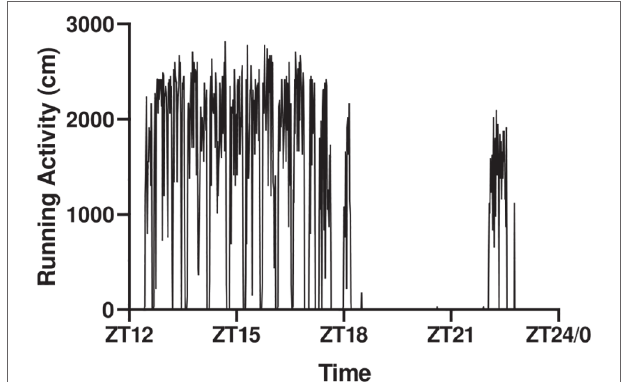
FIGURE 3 | Representative running pattern of a mouse during the active phase.